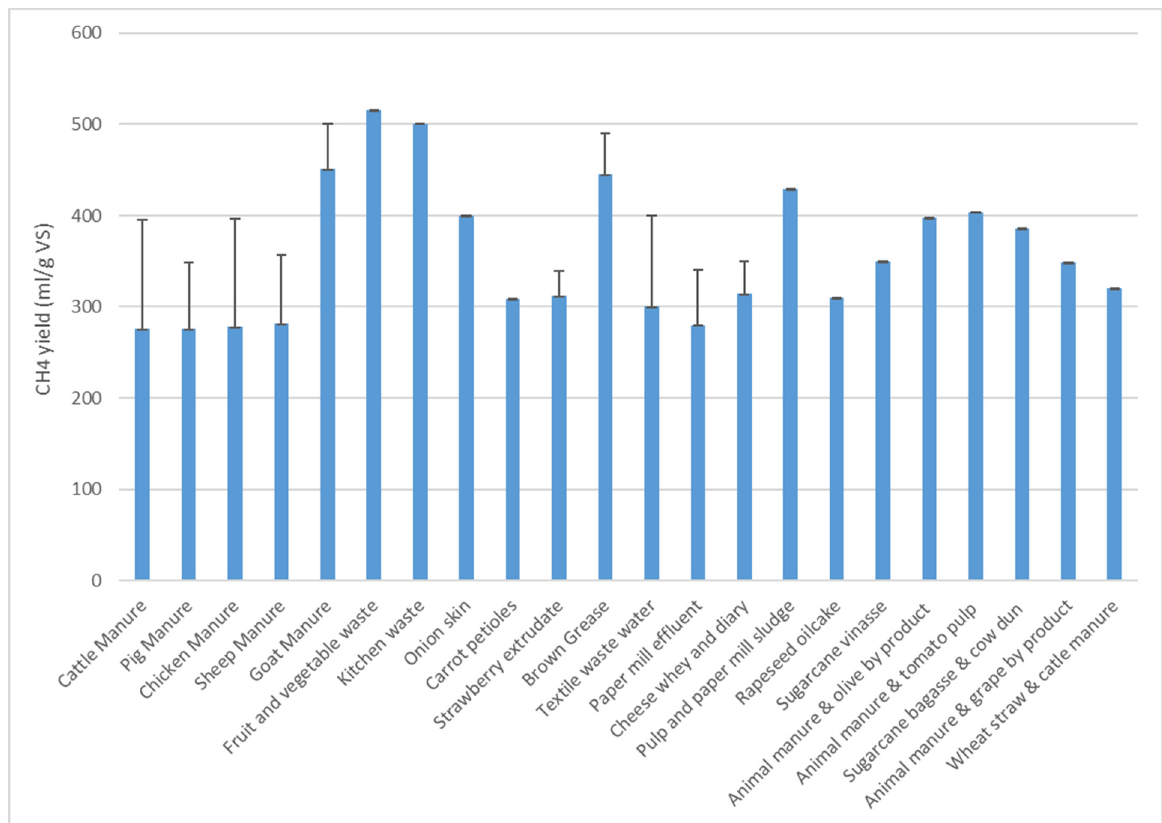
Figure 3. Biogas yield from different substrates with biomethane yield above 200 mL/g VS (according to [30]).